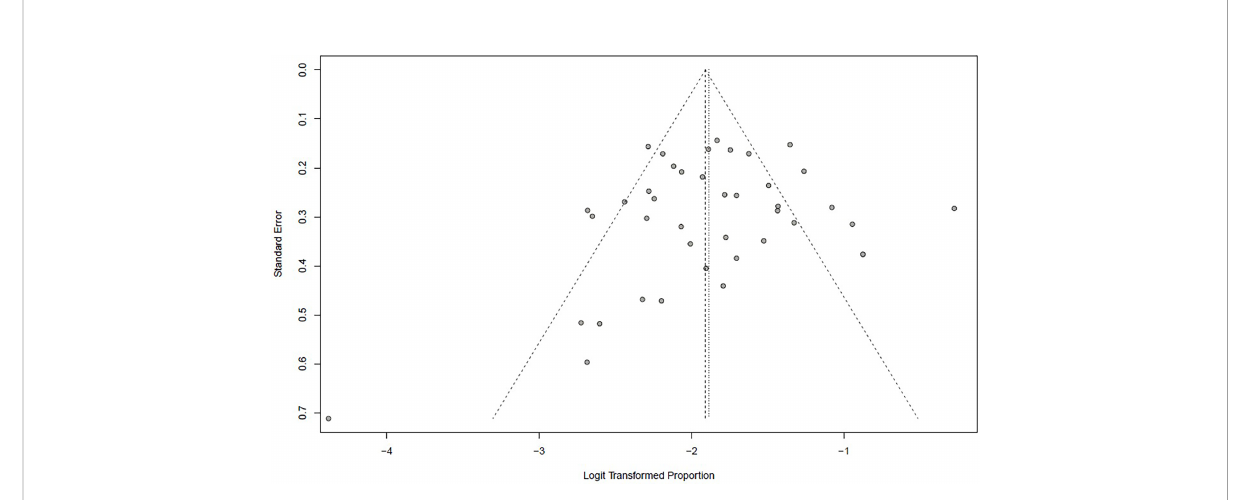
FIGURE 4 Funnel plot illustrating the publication bias of meta-analysis of overall pooled incidence rate of hyperprogressive